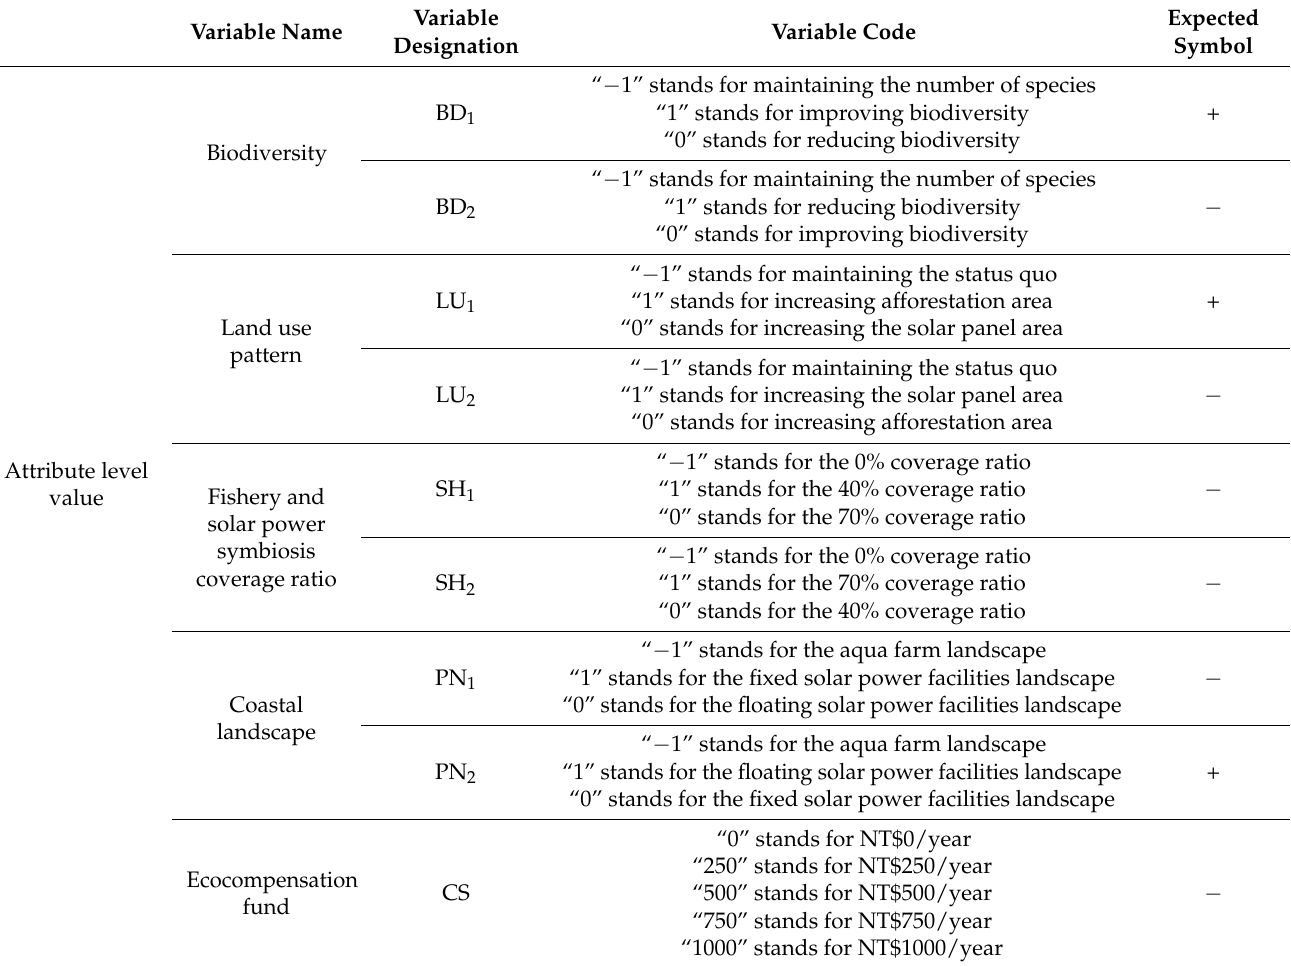
Table 6. Explanation of variables in the empirical